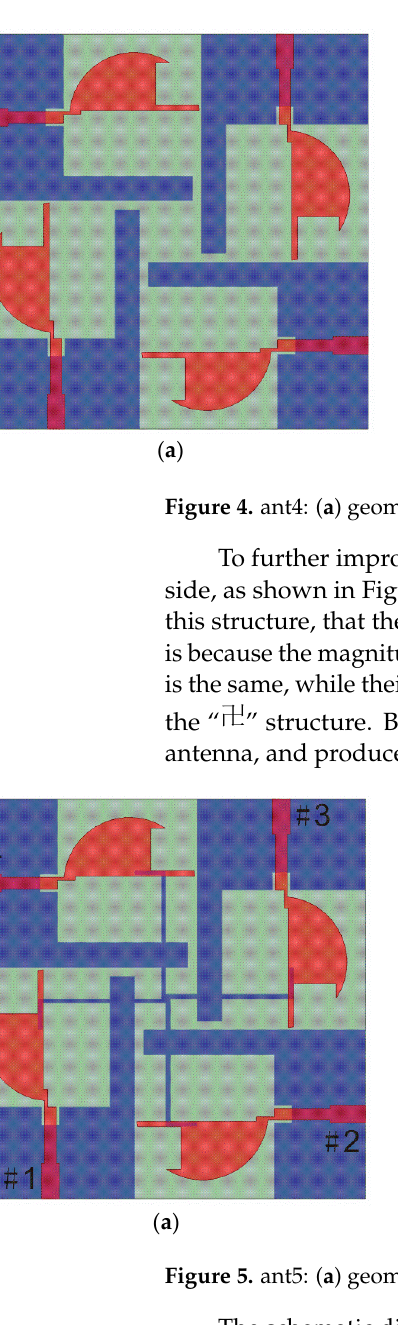
Figure 3. Surface current distribution at 6.5 GHz for ant3.